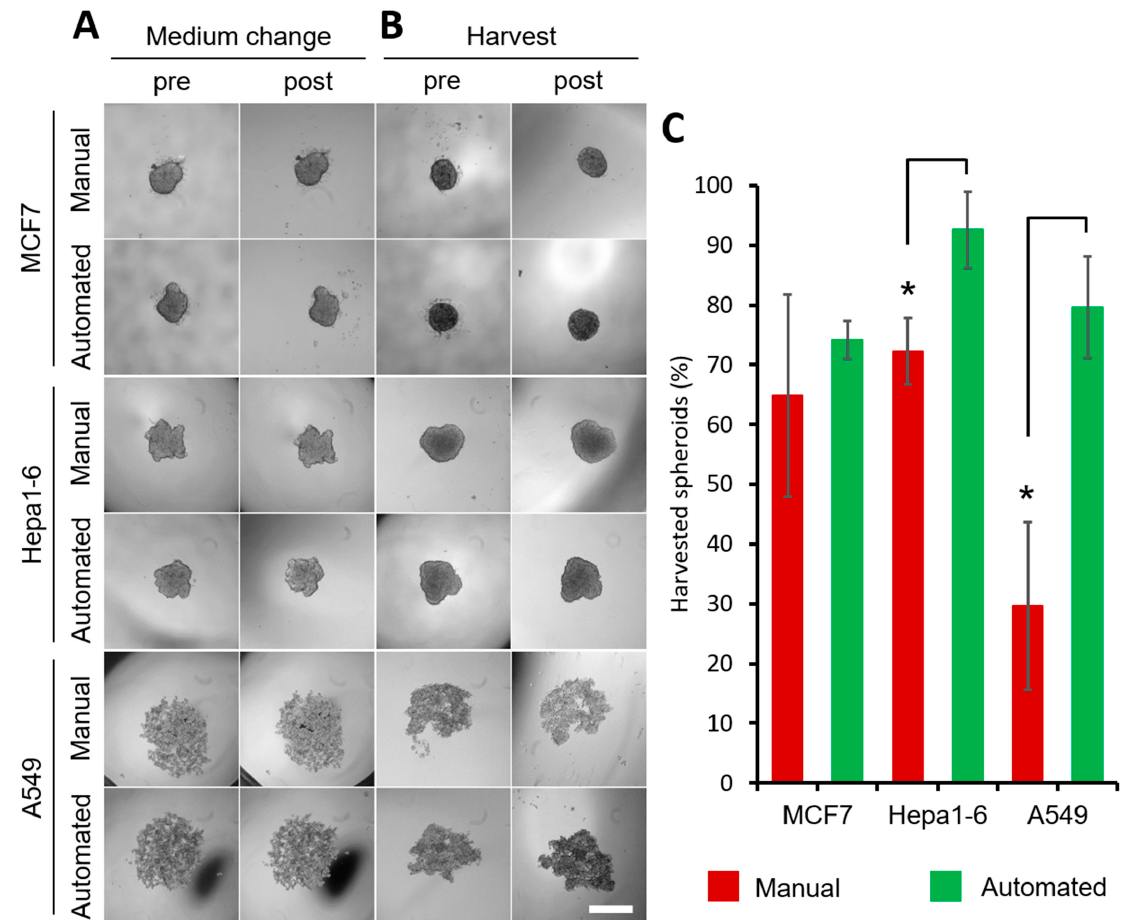
Figure 4. Evaluation of manual and automatic handling of hanging drop cell culture. ( A ) MCF7 and Hepa1-6 spheroids on day 2, A549 on day 3 before and after medium change. ( B ) MCF7, Hepa1-6 spheroids harvested on day 3, A549 spheroids harvested on day 5 before and after harvesting. 5000 cells were initially seeded, scale bar 500 µm. ( C ) Efficiency of spheroid harvest with automated and manual handling, n = 3 with 18 spheroids per n, * p < 0.05 significant differences between automated and manual harvest, red: manual harvest, green: automated harvest.